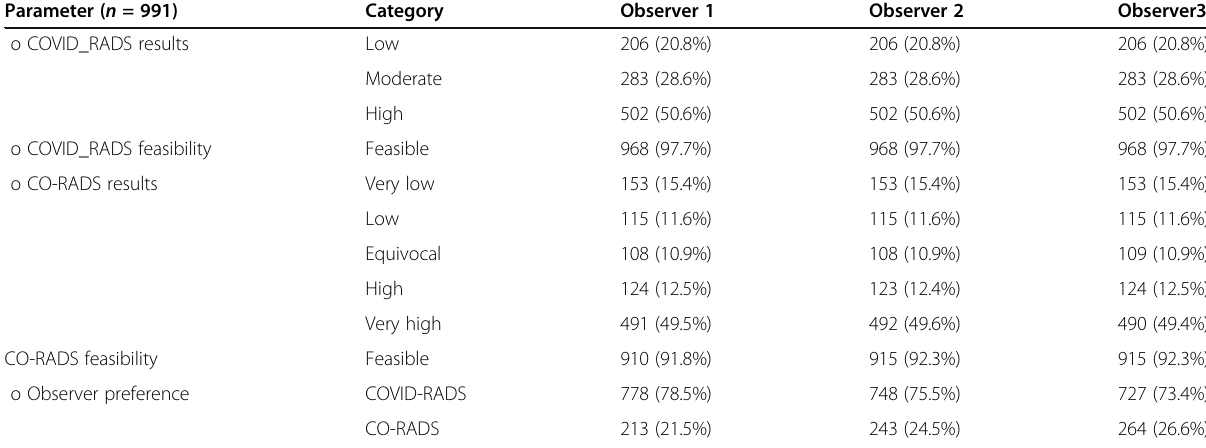
Table 2 Diagnostic findings according to observers and different levels of suspicion of COVID affection